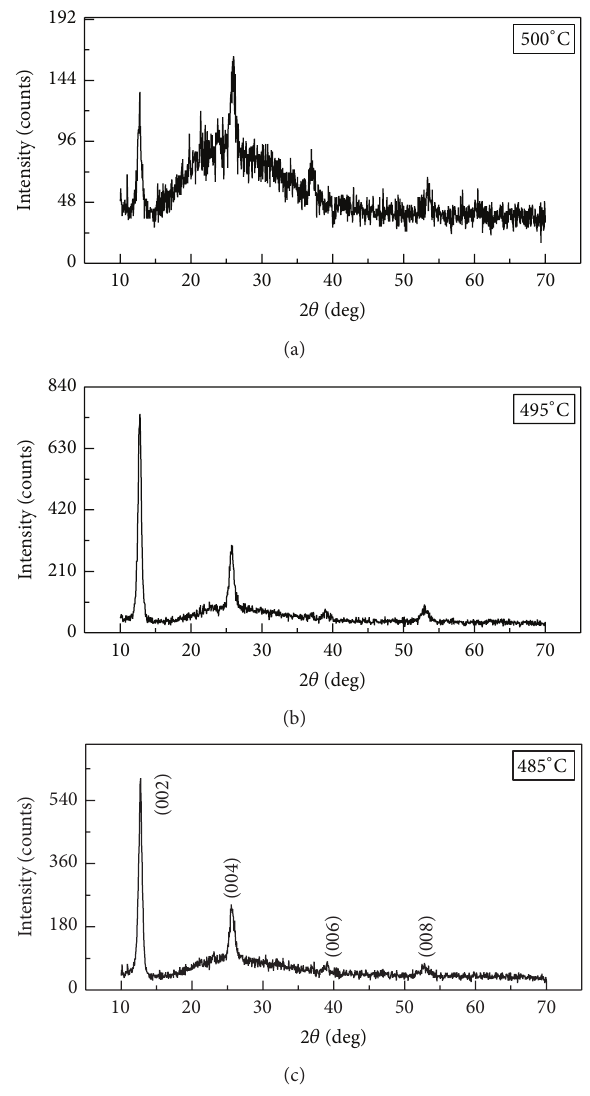
Figure 3: XRD patterns of Mo-Te thin films with a thickness of 450 nm annealed at 485 ∘ C, 495 ∘ C, and 500 ∘ C for 15 minutes in N 2